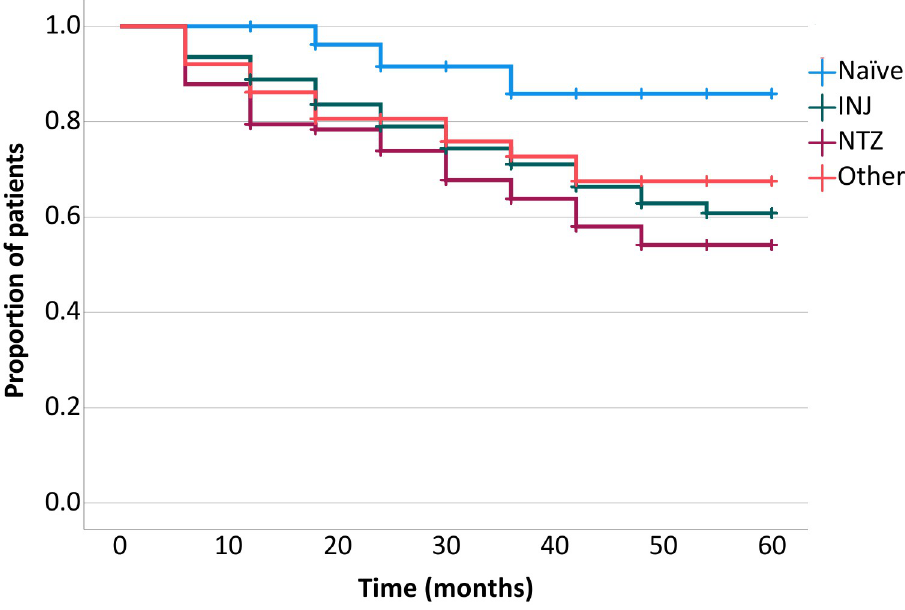
Fig 4. Kaplan-Meier estimates of time to proportion of patients with stable EDSS. Note : Log rank p = 0.033.